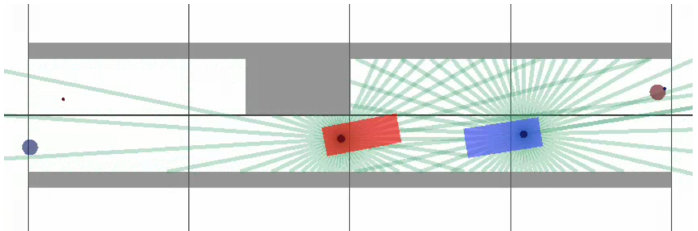
Figure 2. The multiagent maneuvering environment with an example scenario of a bottleneck and two cars trying to negotiate safe passage through it. The color-coded goals of the respective agents are shown in the form of circles, while the green rays are the visualization of the freespace